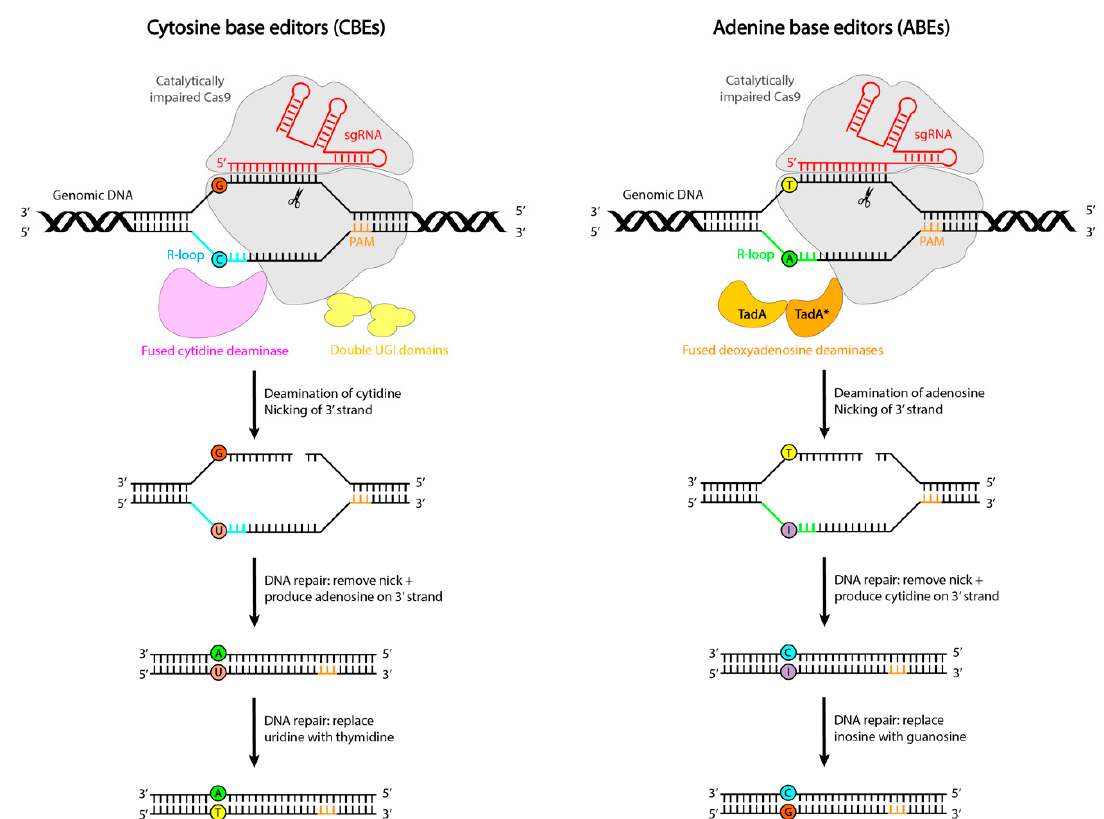
Figure 2. Mechanisms of installing transition point mutations with base editors. ( Left ) Cytosine base editor and ( Right ) adenine base editor.